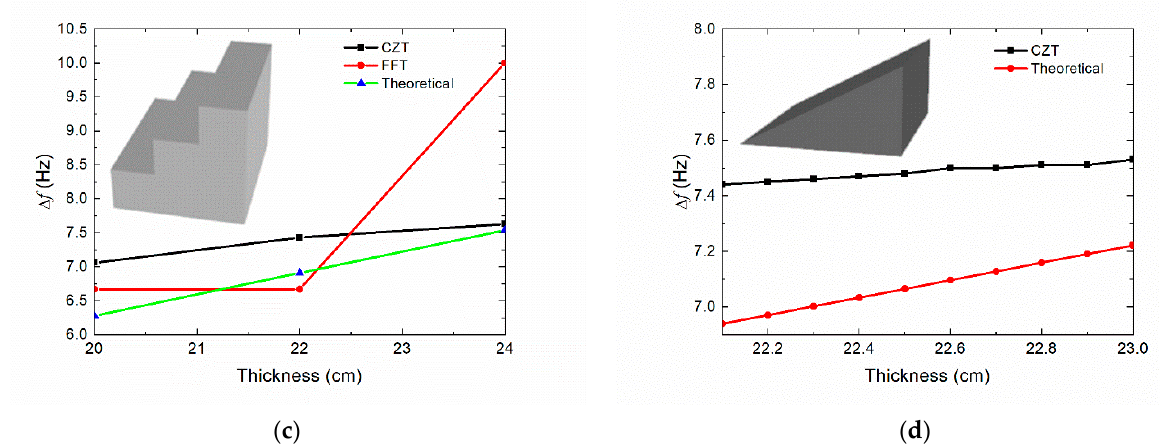
Figure 2. FFT and CZT algorithm simulation: ( a ) An IF signal with frequencies of 6 and 10 Hz. ( b ) Spectral analysis of IF signals by FFT and CZT algorithms. ( c ) FFT and CZT calculations for samples with thicknesses of 20, 22, and 24 cm. ( d ) CZT calculates samples with a linear thickness growth from 22 to 23 cm.